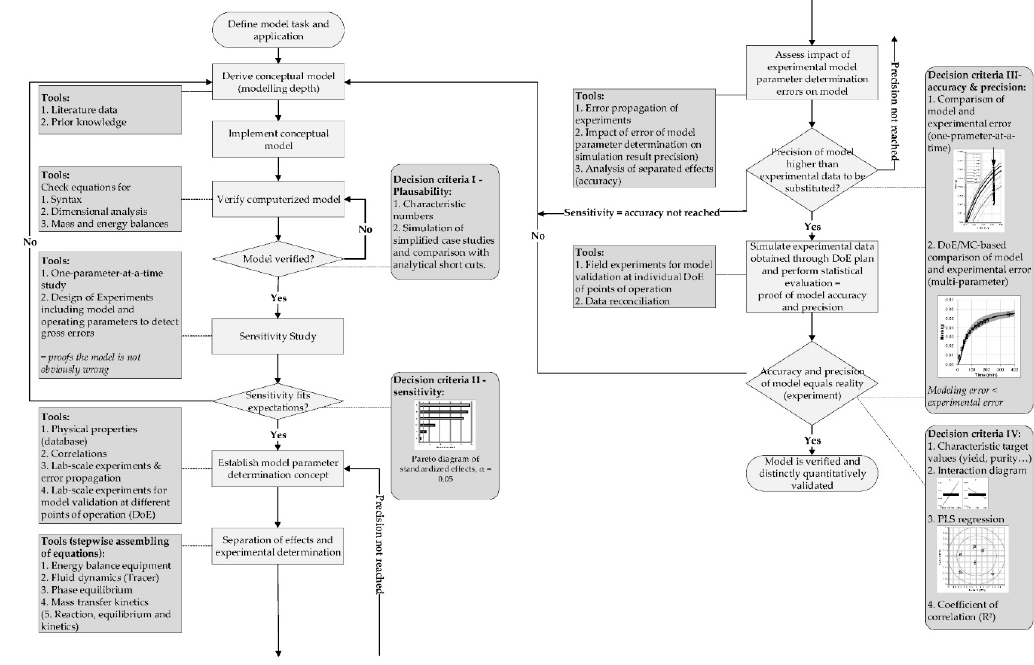
Figure 3. Workflow for Process- and model development [26]. Reproduced with permission from A. Schmidt, Processes; published by MDPI,